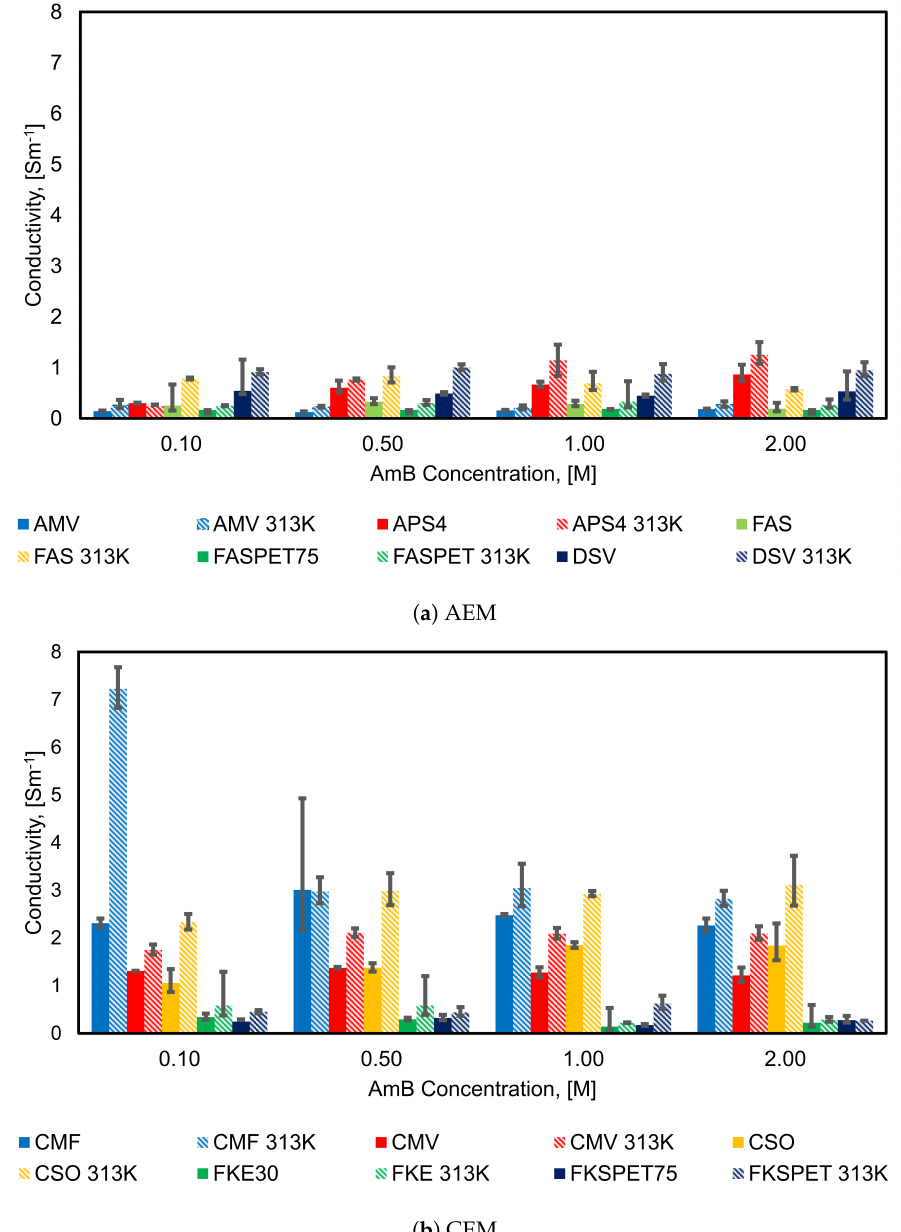
Figure 9. Effect of the solution concentration on the IEM